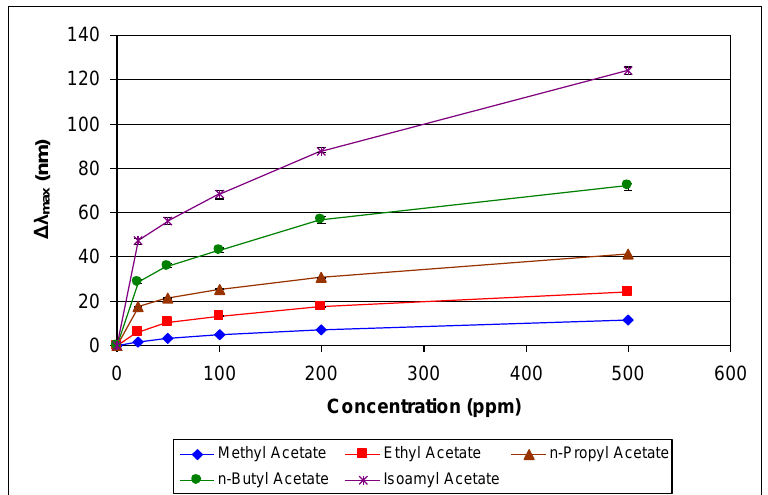
Figure 9. Response of sensor to acetates at various